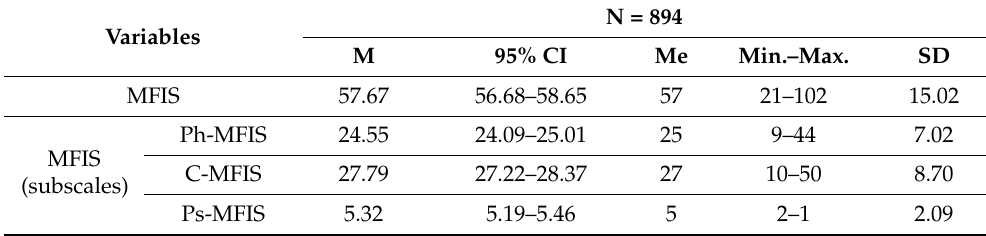
Table 2. Descriptive statistics of the analyzed